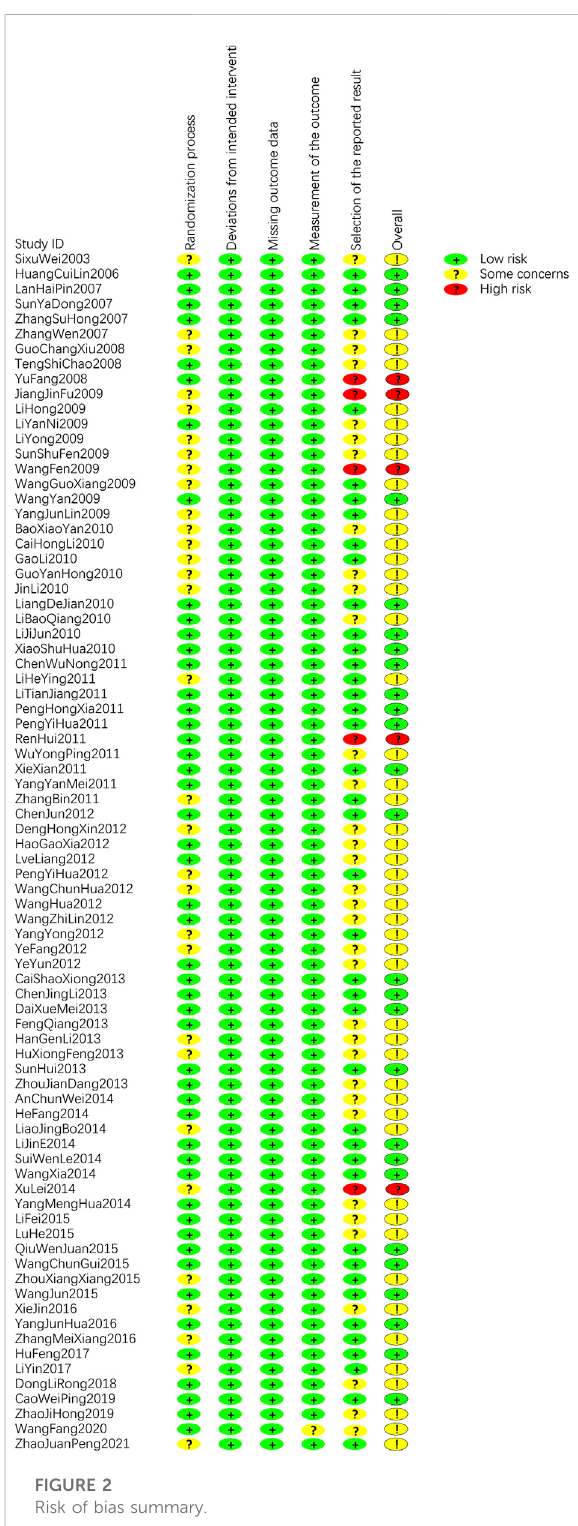
FIGURE 2 Risk of bias